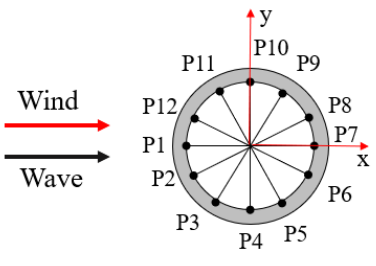
Figure 5. Top view of tower base.